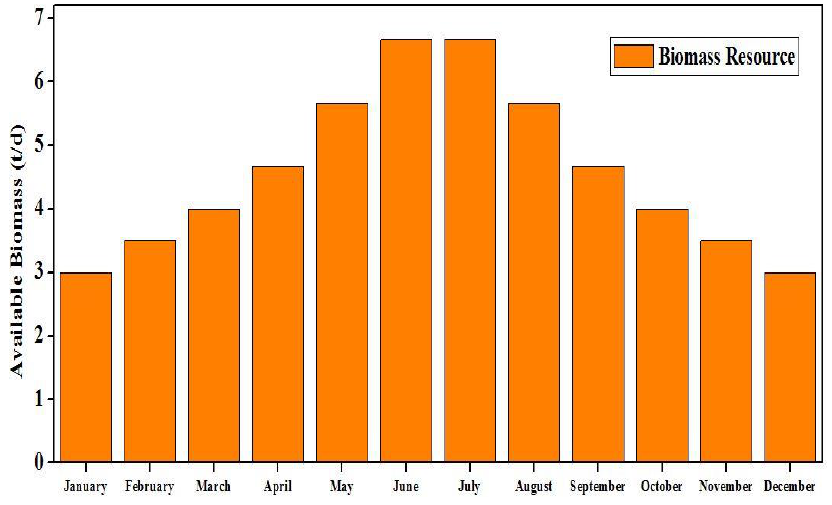
Figure 7. Monthly average biomass resources of Yupia [54].